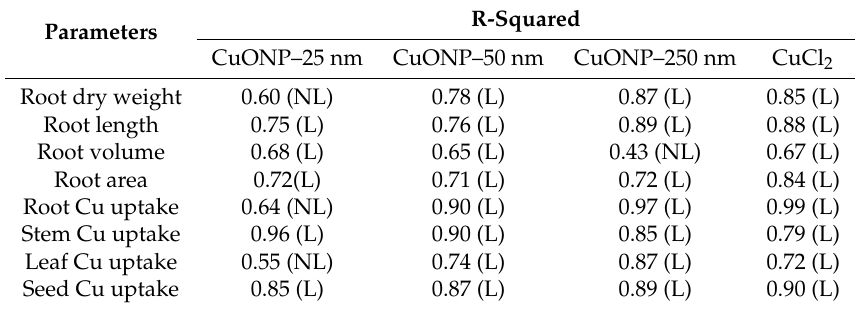
Table 4. Coe ffi cient of determination (R-squared value) from the linear regression for various parameters tested for di ff erent sized CuONP and CuCl 2 treatments in soil-grown